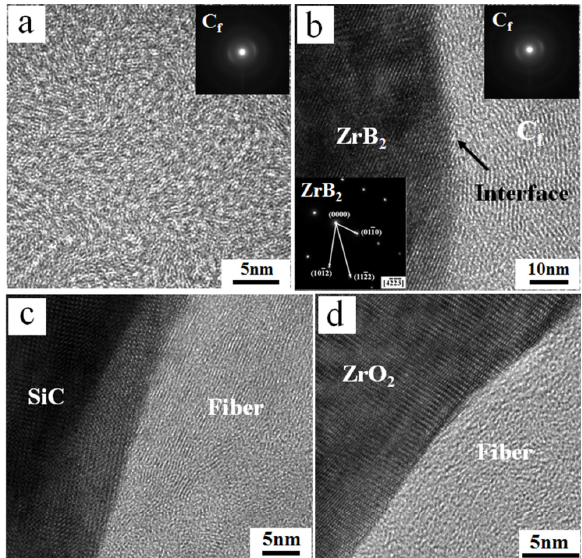
Fig. 5 HR-TEM images of (a) original structure of the raw carbon fiber and (b) ZrB 2 /C f , (c) SiC/C f , and (d) ZrO 2 /C f interfaces of ZSC30, showing a typical non-ordered graphite structure of C f and clear fiber/ceramic interfaces. The insets in (a) and (b) are the SAED patterns of C f and ZrB 2 .